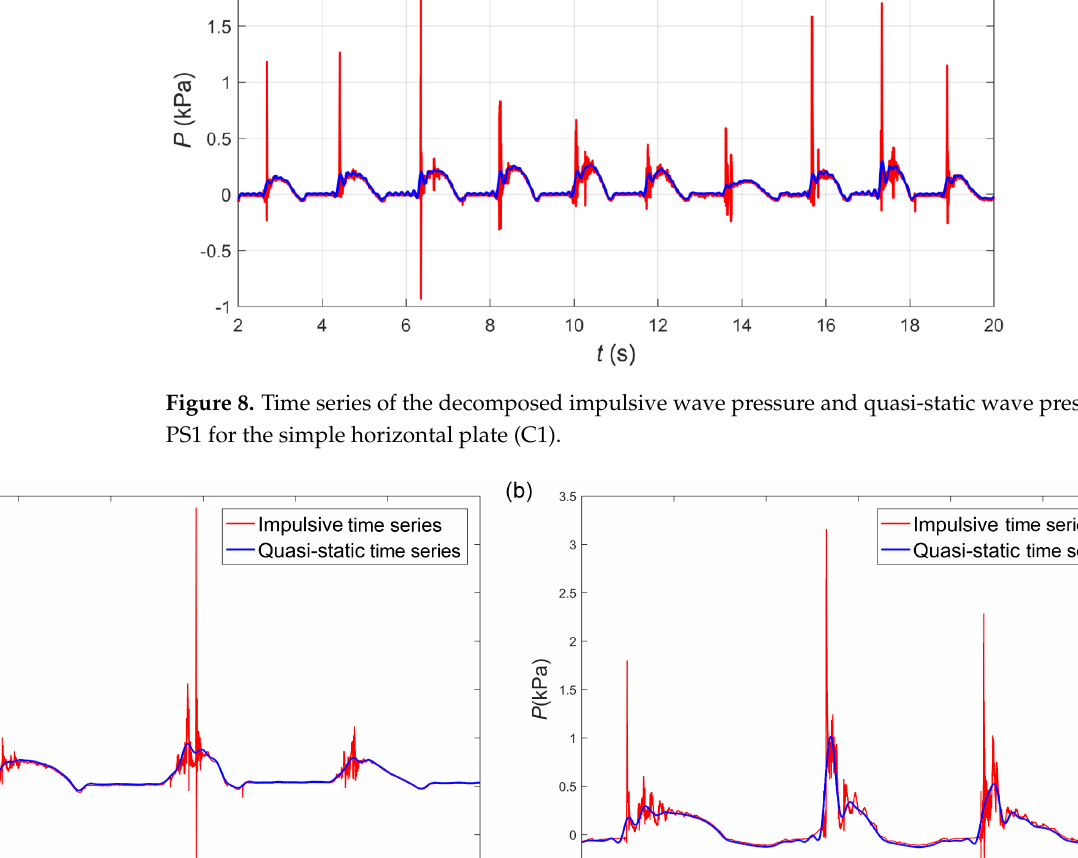
Figure 9. Time series of the decomposed impulsive wave pressure and corresponding reconstructed quasi-static wave pressure for the vertical wall with horizontal cantilever slab (C2) for measurements at ( a ) pressure sensor PS1 and ( b ) pressure sensor